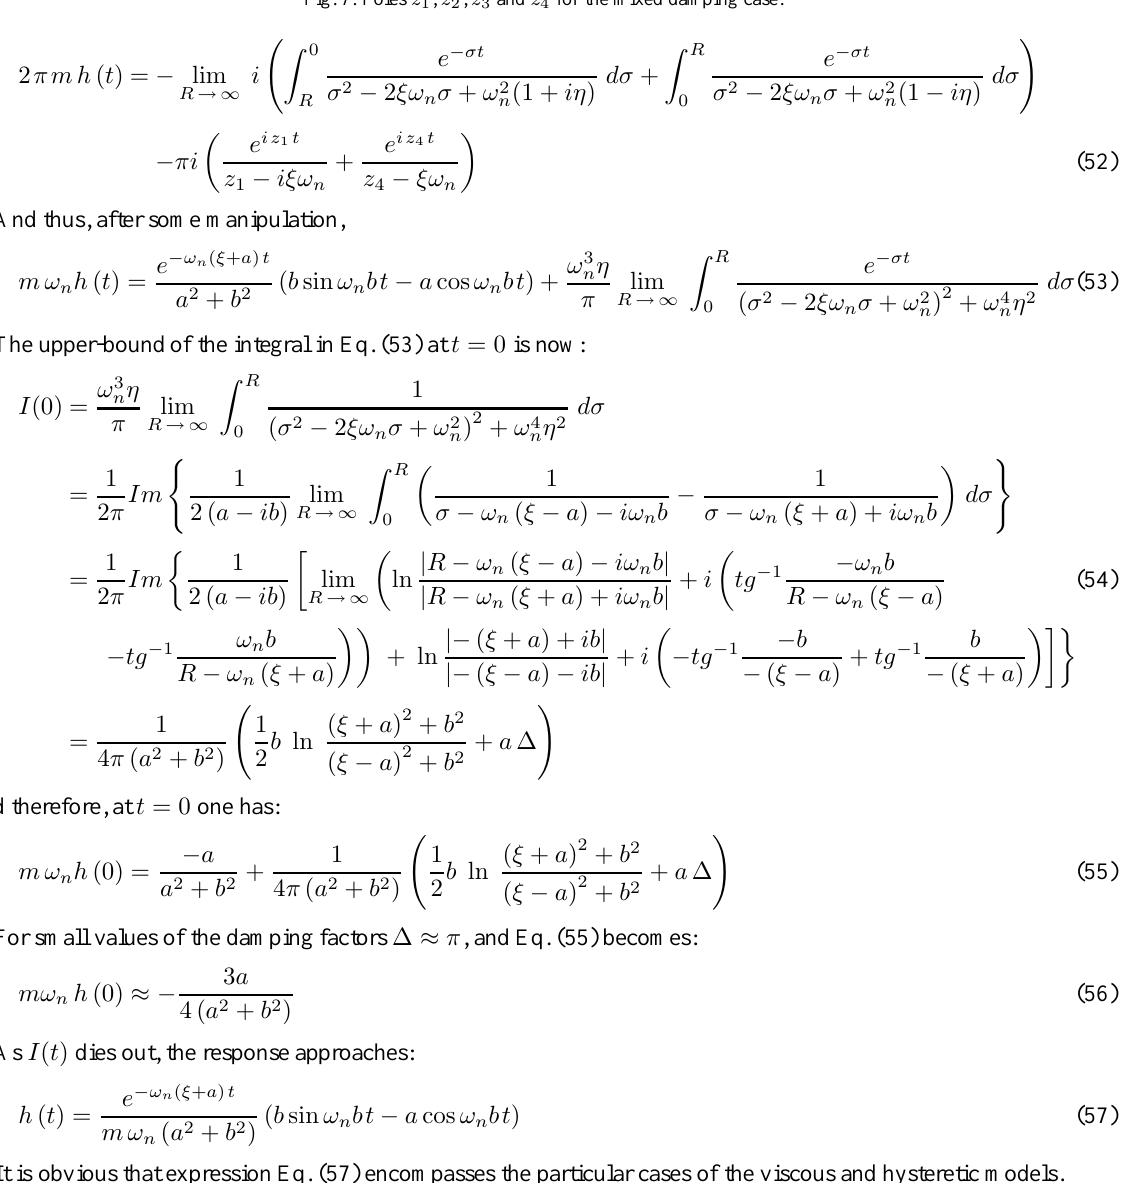
Fig. 7. Poles z 1 , z 2 , z 3 and z 4 for the mixed damping